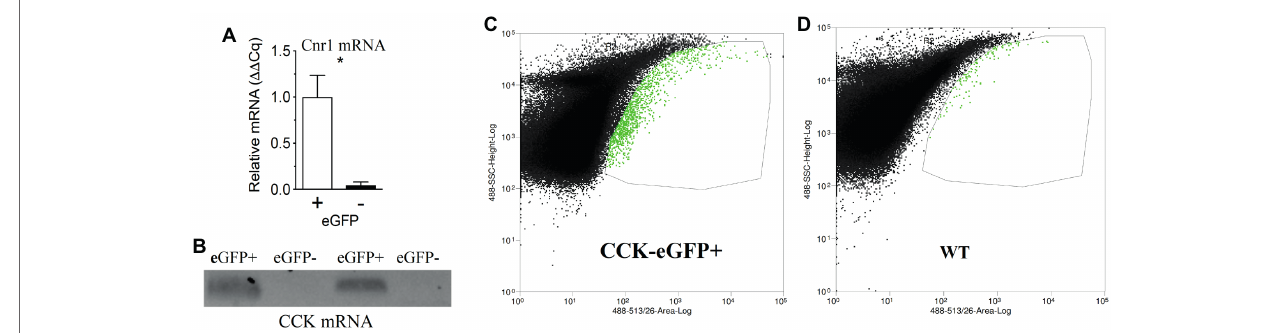
FIGURE 2 | CB1R mRNA expression is enriched in CCK-containing cells in the upper small-intestinal epithelium. Fluorescence-activated cell sorting (FACS) of eGFP-CCK-positive (+) and eGFP-CCK-negative (−) cells from the upper small-intestinal epithelium reveals enhanced Cnr1 expression in eGFP-CCK-positive cells (A) . Expression of mRNA for CCK is found in eGFP-CCK-positive cells but not in eGFP-CCK-negative cells (B) . Gating strategy shown for sorting of eGFP-positive and eGFP-negative events, with eGFP-positive cells highlighted in green and demarked by thin line (C) and compared to upper small-intestinal epithelial cells from a wild-type (WT) mouse (D) . Data expressed as mean ± S.E.M. Analyzed using Student’s t -test, two-tailed (C) ; n = 3 per group; * p <